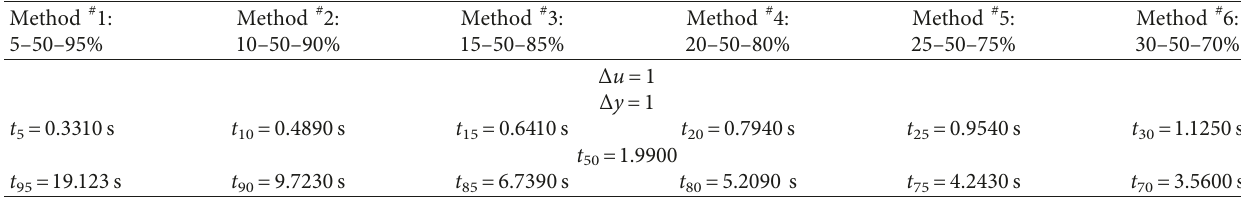
Table 13: Process information for fractional-order model identification of process P